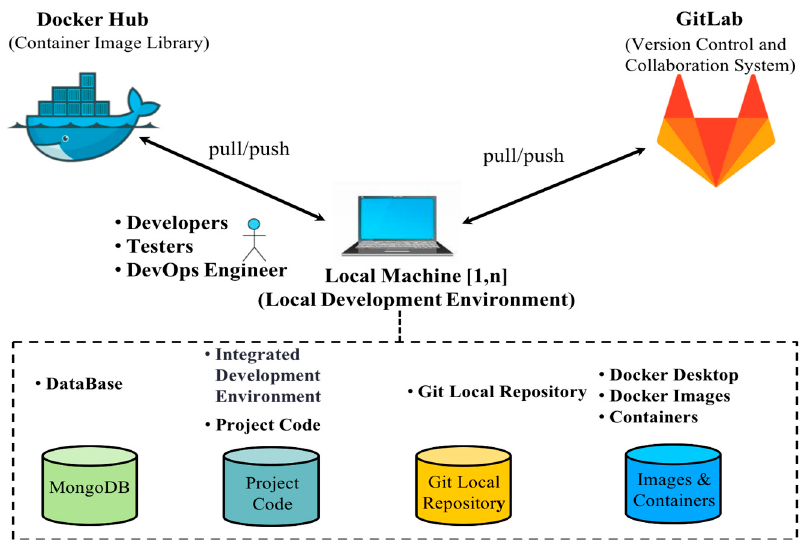
Figure 7. Development